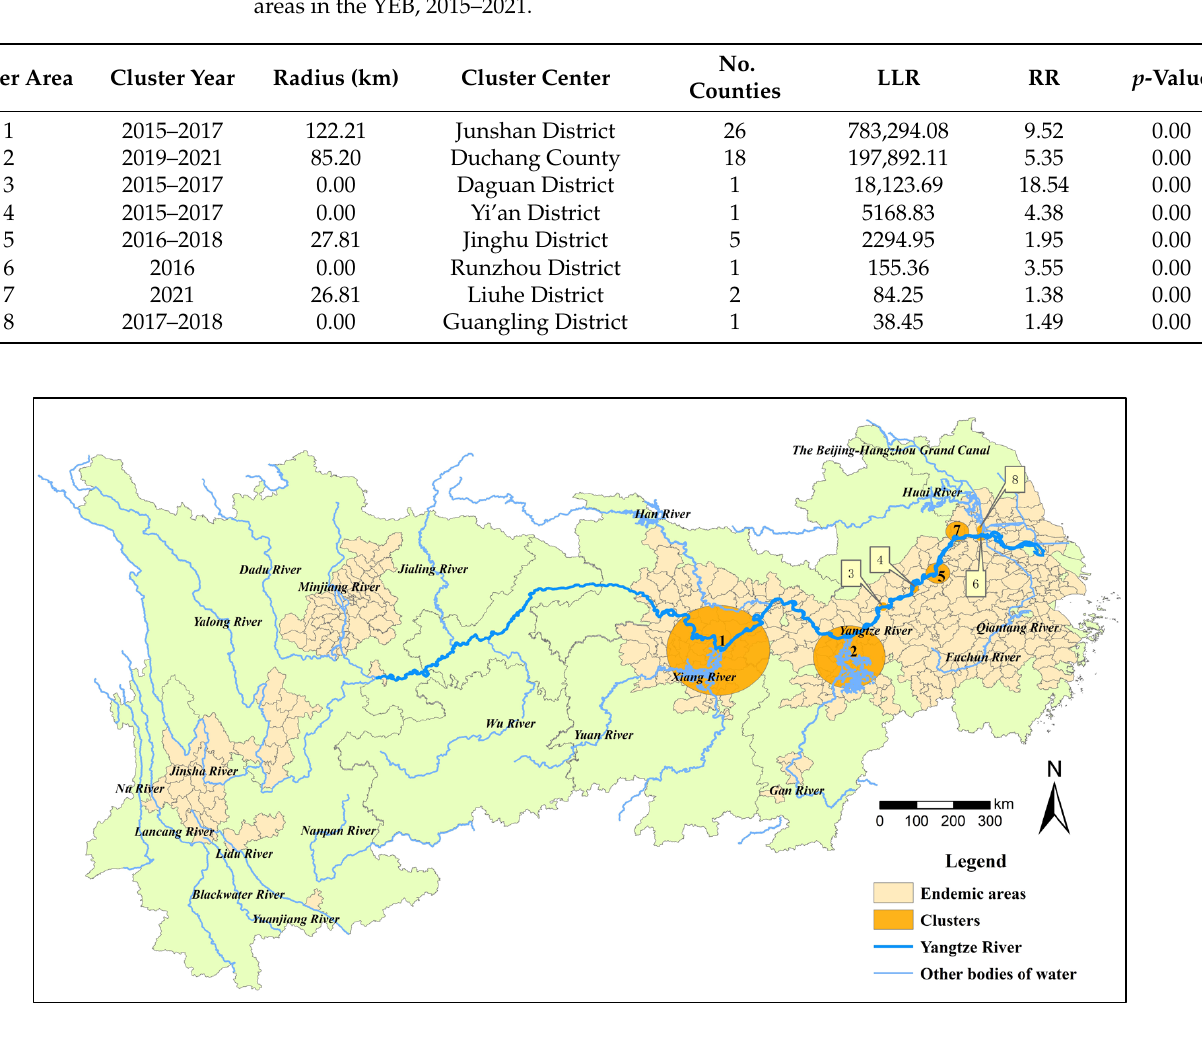
Table 2. Spatiotemporal cluster analysis on the distribution of actual snail habitats in the endemic areas in the YEB, 2015–2021.